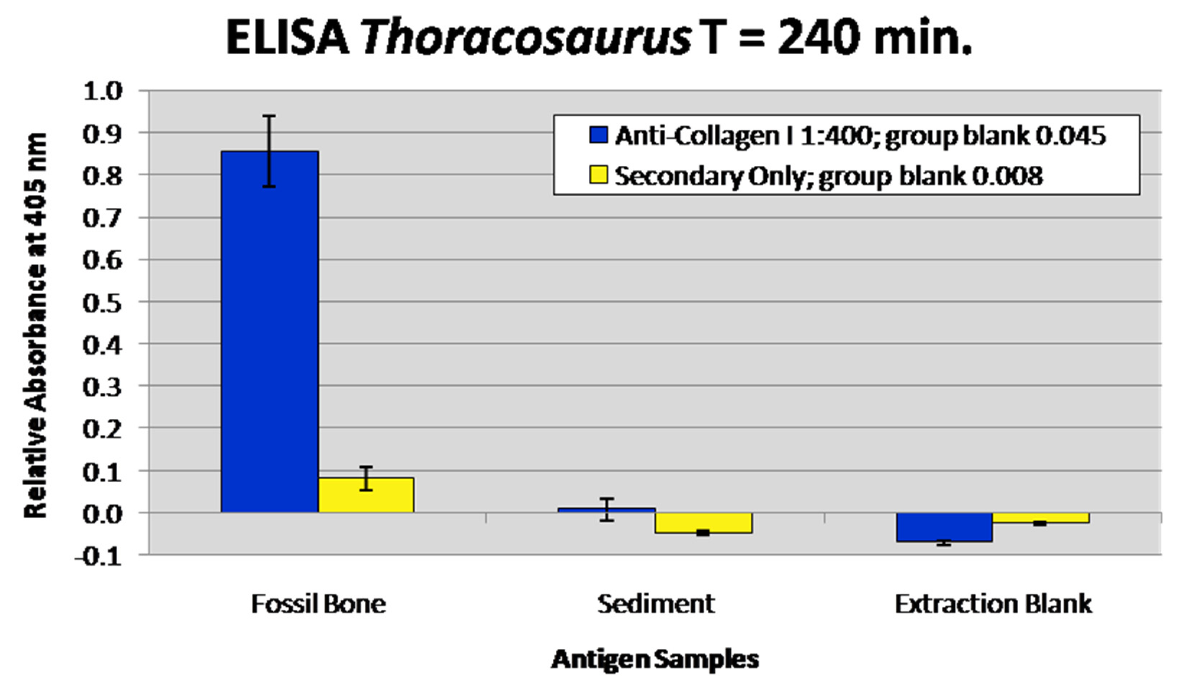
Figure 6. Enzyme-linked immunosorbent assay results of fossil and sediment chemical extracts. Extraction buffers were also run as a negative control to test for contaminants. Fossil and sediment samples were loaded at 200 mg of pre-extracted weight. Blue columns represent absorbance at 405 nm at 240 min, with incubation in anti-chicken collagen I antibodies at a concentration of 1:400. Yellow columns represent the absorbance of the secondary-only controls for each sample. The fossil bone sample is over three times its secondary control and the sediment and extraction blank show low absorbance, indicating that they are not a source for the positive signal in the fossil sample. Error bars represent one standard deviation of the mean absorbance of each sample.